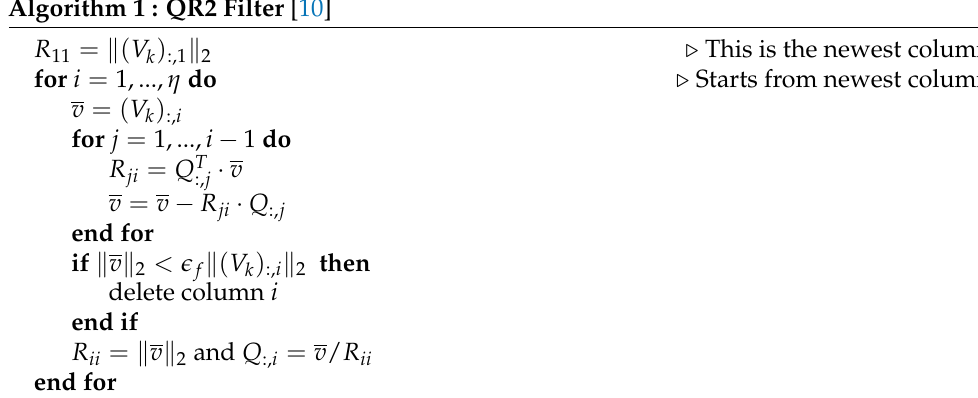
Algorithm 1 : QR2 Filter